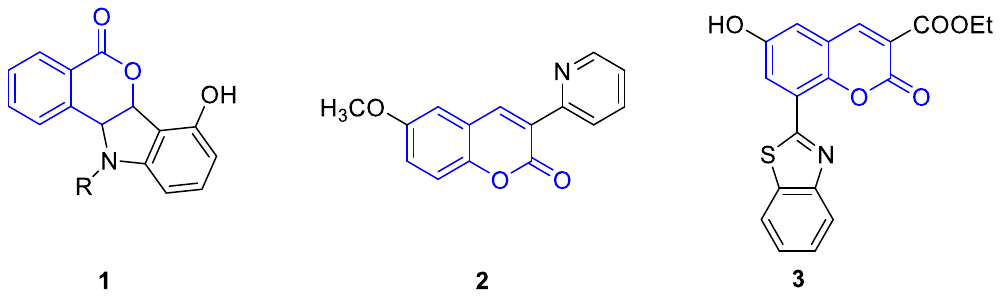
Figure 1. Some coumarin-based fluorescence probes.